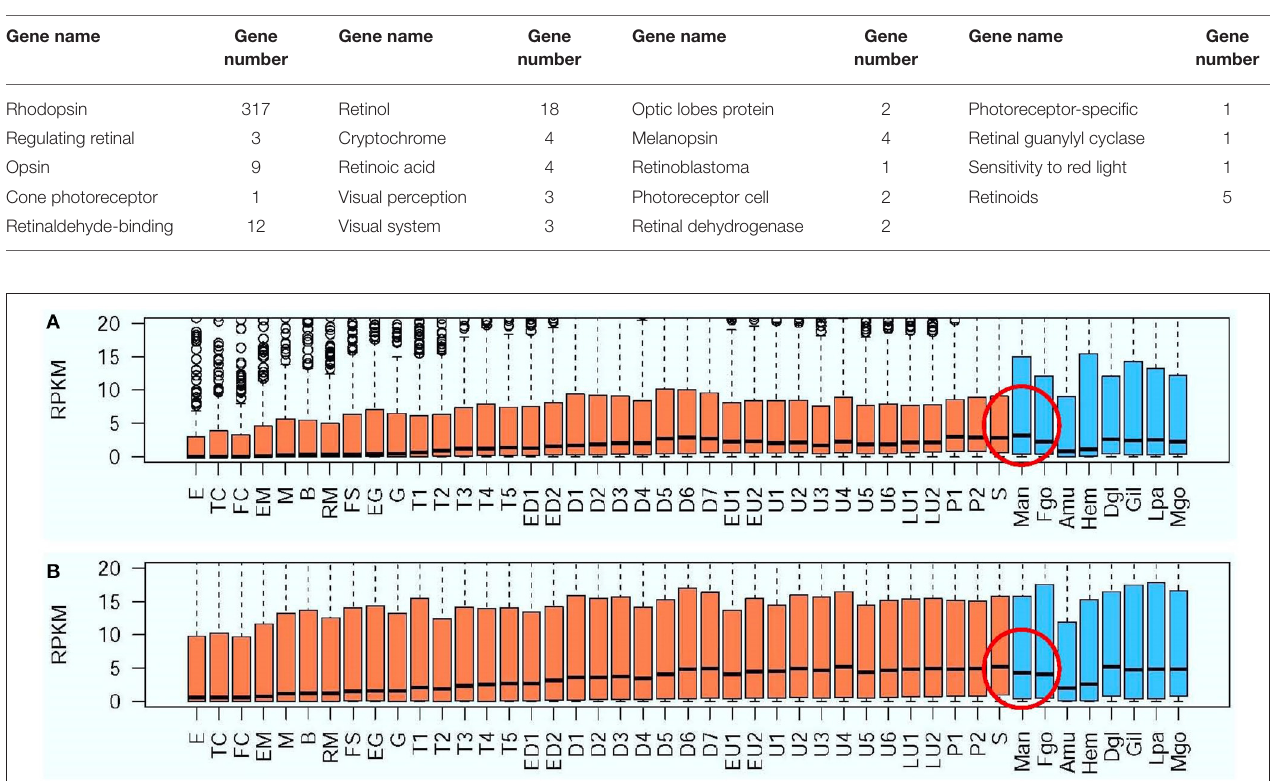
TABLE 3 | The vision-related oyster genes in different function categories.